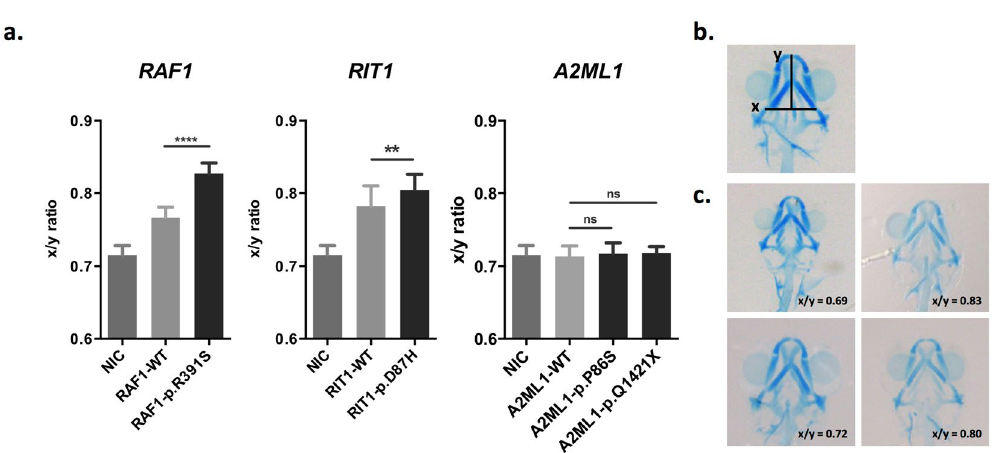
Figure 4. Craniofacial assessment of zebrafish embryos. The zebrafish embryos were treated with Alcian blue and washed with acidic alcohol 3 dpf. The ratio of the width of the ceratohyal (x) to the tip of Meckel’s cartilage (y) was used as a measure of craniofacial defects. ( a ) Comparison of the x-to-y ratio between mutant and wild- type zebrafish embryos. The data are the mean ± SD. Statistical significance was derived using an unpaired t-test comparing the mutants with the corresponding WT. ** p < 0.01; **** p < 0.0001; ns: not significant. NIC: No injection control. The number in bold represents the total count of zebrafish embryos in the experimental group. ( b ) Alcian-blue stained cartilage in the zebrafish. The x-axis shows the width of the ceratohyal, and the y-axis shows the length of the tip of Meckel’s cartilage. ( c ) Representative embryos with different x-to-y